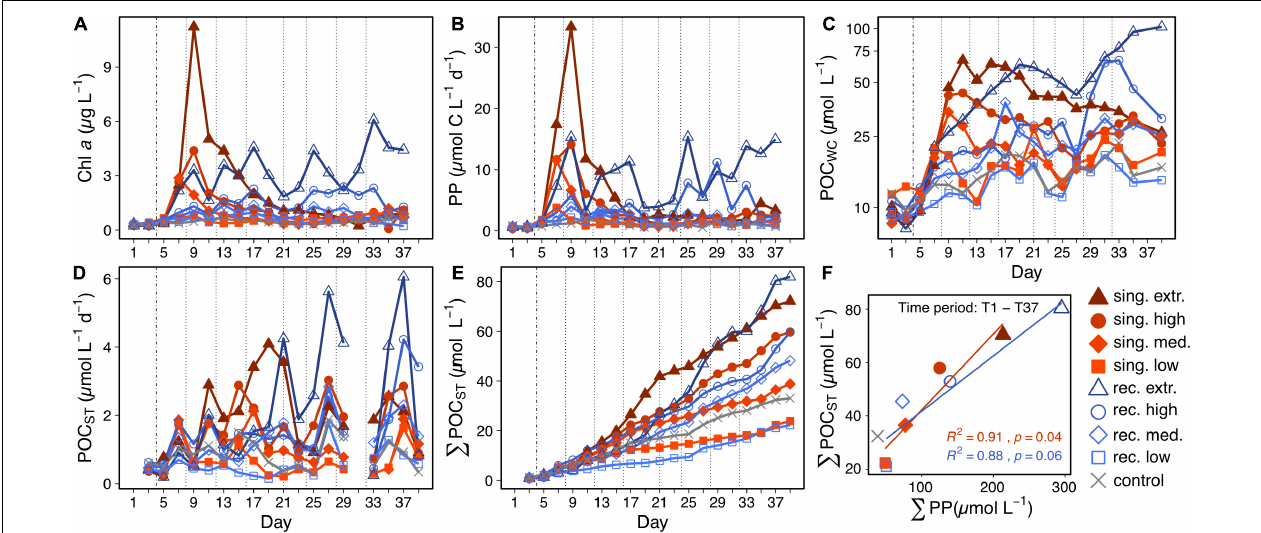
FIGURE 2 | Chl a concentration (A) , primary productivity (B) , suspended POC concentration in the water column (C) , POC mass flux to the sediment trap (D) , and cumulative mass flux (E) during the 39 day experiment. The vertical lines indicate the deep water additions with the dashed one on the left representing the one for the singular and recurring treatment, the dotted ones being the following recurring additions. (F) Shows the correlation between the cumulative POC flux and the cumulative primary productivity on T37. Regression lines are plotted in the color of the corresponding upwelling mode (singular or recurring) and exclude the control data point. Regression equations are provided in Supplementary Table 1